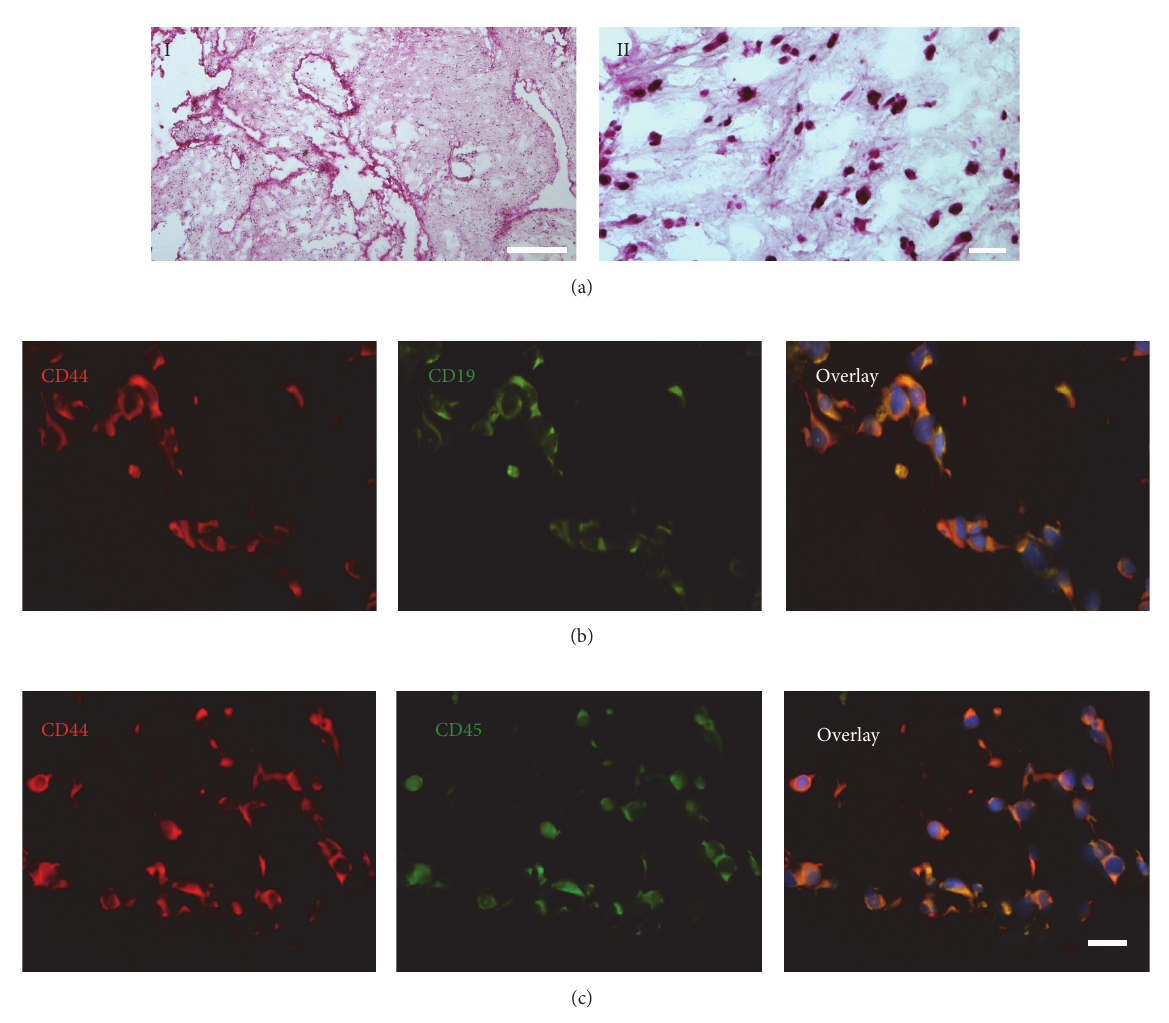
Figure 1: Phenotypic characterization of atrial myxoma. (a) Typical morphological features of myxoma by hematoxylin and eosin (HE) staining. Myxoma cells were dispersed within abundant myxoid matrix. Scale bar = 100 𝜇 m (I), =20 𝜇 m (II). (b) Myxoma cells were CD44 and CD19 double positive as confirmed by immunostaining. (c) Immunohistochemical characterization of myxomas revealed that myxoma cells were CD44 and CD45 double positive. Scale bar = 20 𝜇 m (b &